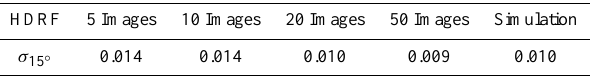
Table 2. Standard deviation σ 15 ◦ of the mean HDRF using 5, 10, 20 or 50 images calculated for a circle of zenith angles lower than 15 ◦ . Additionally, σ 15 ◦ is given for a plane-parallel cloud of optical thickness τ = 12 and particle effective radius R eff =